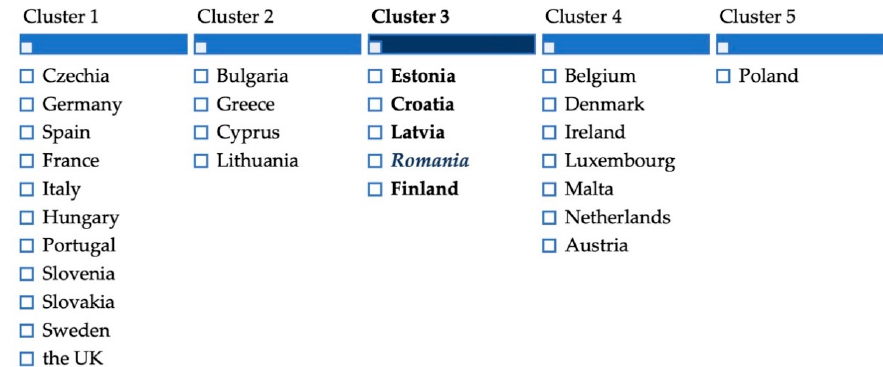
Figure 6. European Member State clusters based on Just Transition Indicators.